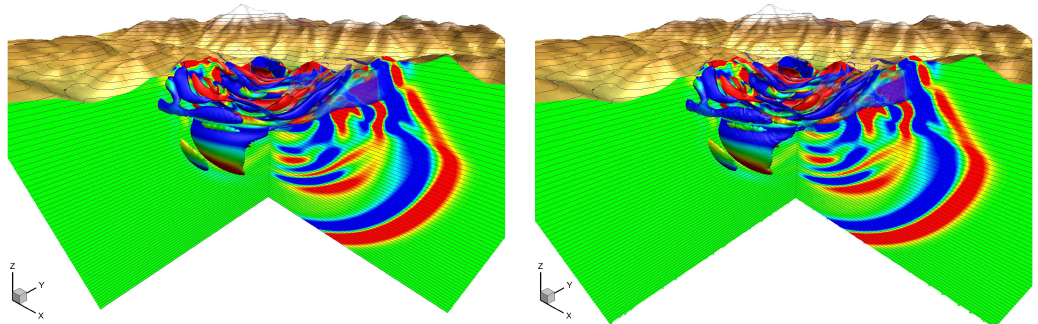
Figure 2. Wave field of a seismic wave propagation problem with the novel diffuse interface approach on adaptive Cartesian grids developed in Reference [118] ( left ) compared with the reference solution obtained on a classical boundary-fitted unstructured tetrahedral mesh [119] ( right ).